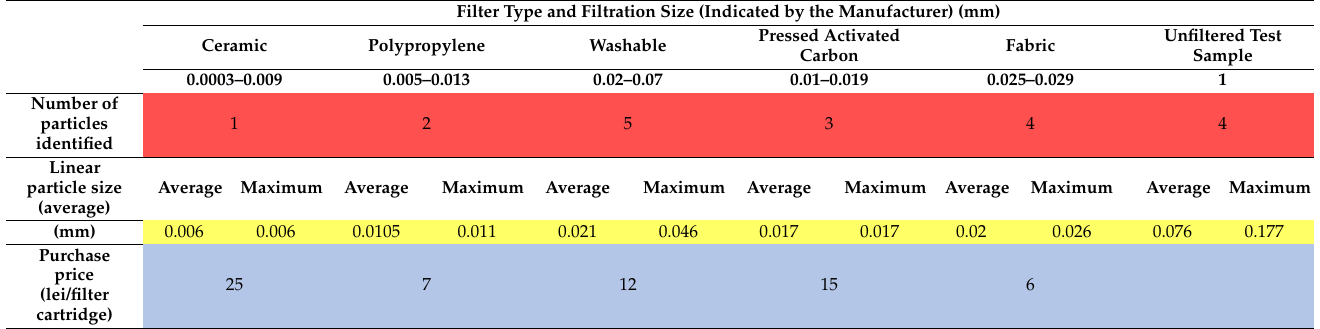
Table 3. Centralized data on filtering capacity, tests and analyses results, and the purchase